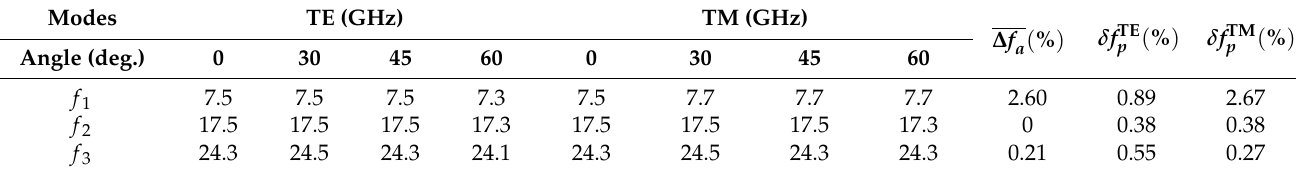
Table 3. The resonance frequency and offset of the proposed FSS for different waves incident modes at different angles. Modes